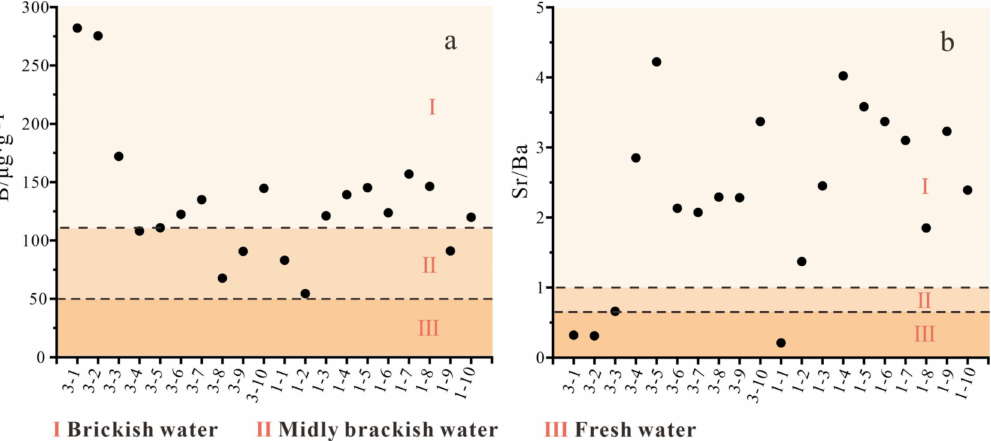
Figure 7. Variations in boron abundance ( a ) and the Sr/Ba ratio ( b ) of the Shanxi Formation in